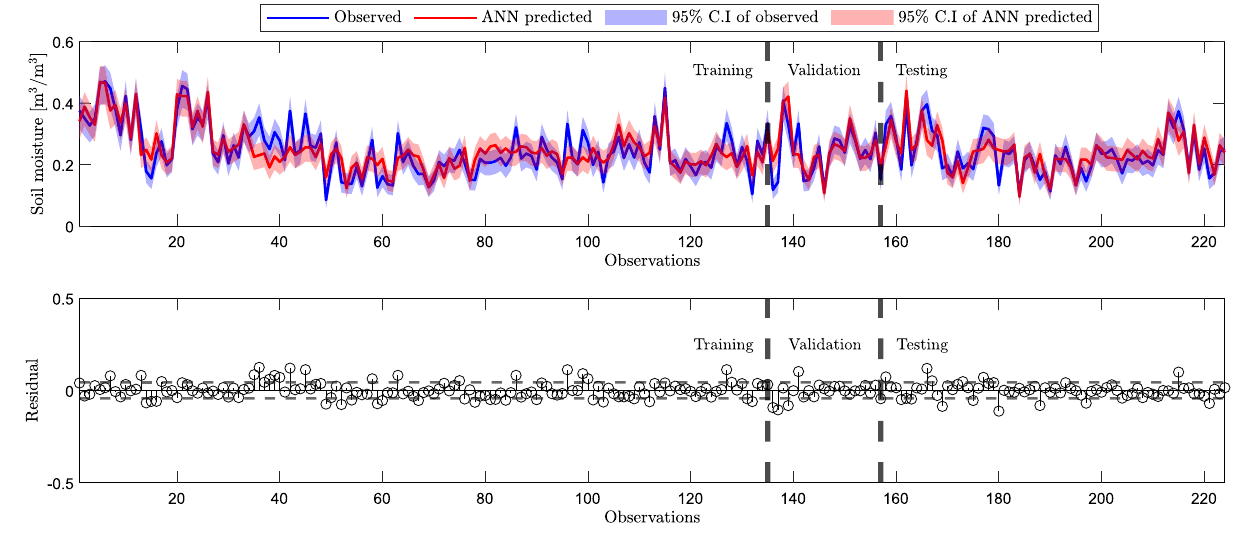
Figure 10. The top panel shows the line plot of observed and predicted soil moisture plotted for training, validation, and testing. The bottom panel shows the corresponding residual plot. The height of the vertical line with a circular cap represents the magnitude of the residual. The dashed line represents the overall RMSE